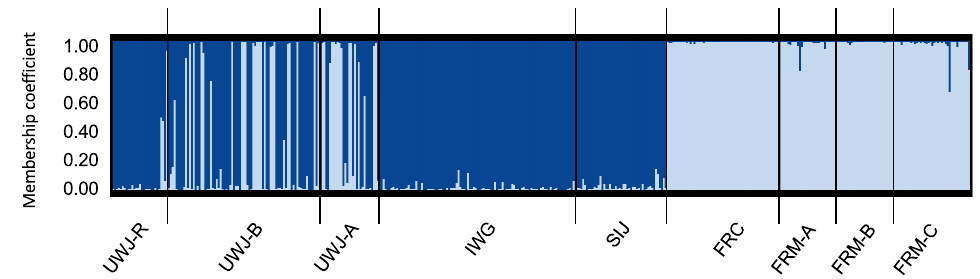
Fig. 2. Results from analysis using STRUCTURE of wild-caught red sea bream (UWJ, IWG, and SIJ), seedlings for stock enhancement (FRC), and broodstock of farmed fi sh (FRM) used in this study.